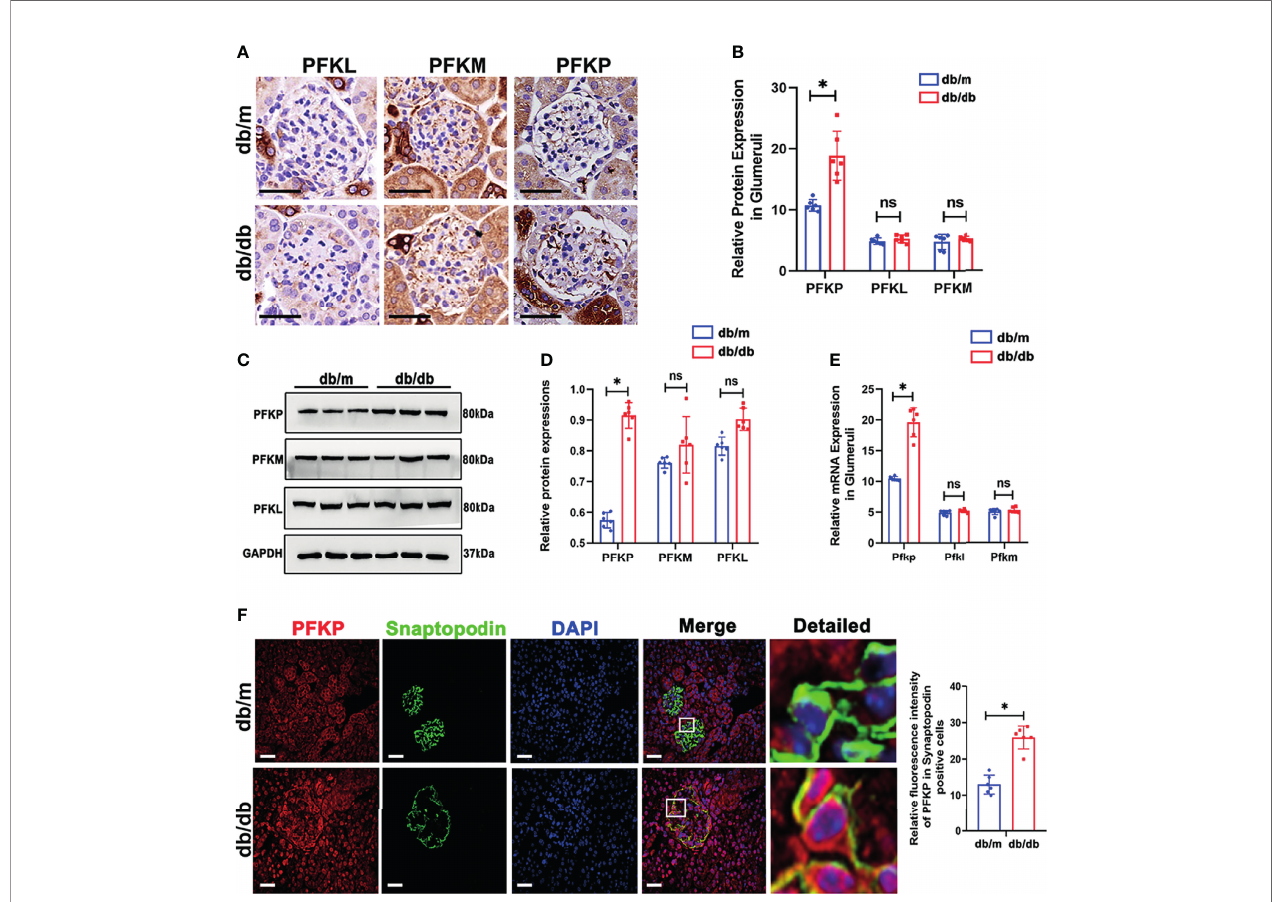
FIGURE 2 | PFK expressions in db/m and db/db mice. (A, B) Representative immunohistochemistry staining of glomerular PFKP, PFKM and PFKL in db/m and db/ db mice. (C, D) Western blotting analysis of the expression of PFKP, PFKM and PFKL in glomeruli of db/m and db/db mice. GAPDH was used as the loading control. (E) Relative mRNA expression of Pfkp, Pfkm and Pfkl in glomeruli of db/m and db/db mice determined by real-time PCR. (F) Representative immuno fl uorescent staining of PFKP in podocyte of glomeruli from db/m and db/db mice. Synaptopodin was used as podocyte markers. For all fi gures, n=6 independent experiments/group. In all statistical plots, * P < 0.05, ns, No signi fi cance. Scale bars: 20 µm, PFKP, phosphofructokinase 1 platelet type; PFKM, phosphofructokinase 1 muscle type; PFKL, phosphofructokinase 1 liver